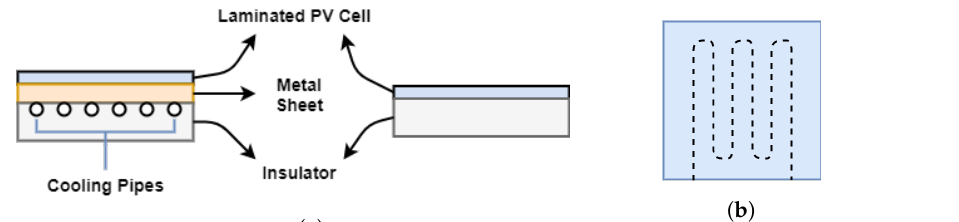
Figure 2. A cross section of the PV/T and PV modules ( a ), and layout of the water-type cooling pipe ( b